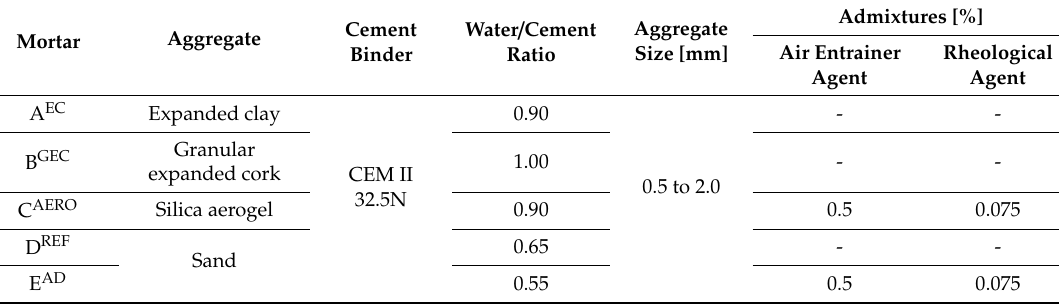
Table 1. Composition of the mortars